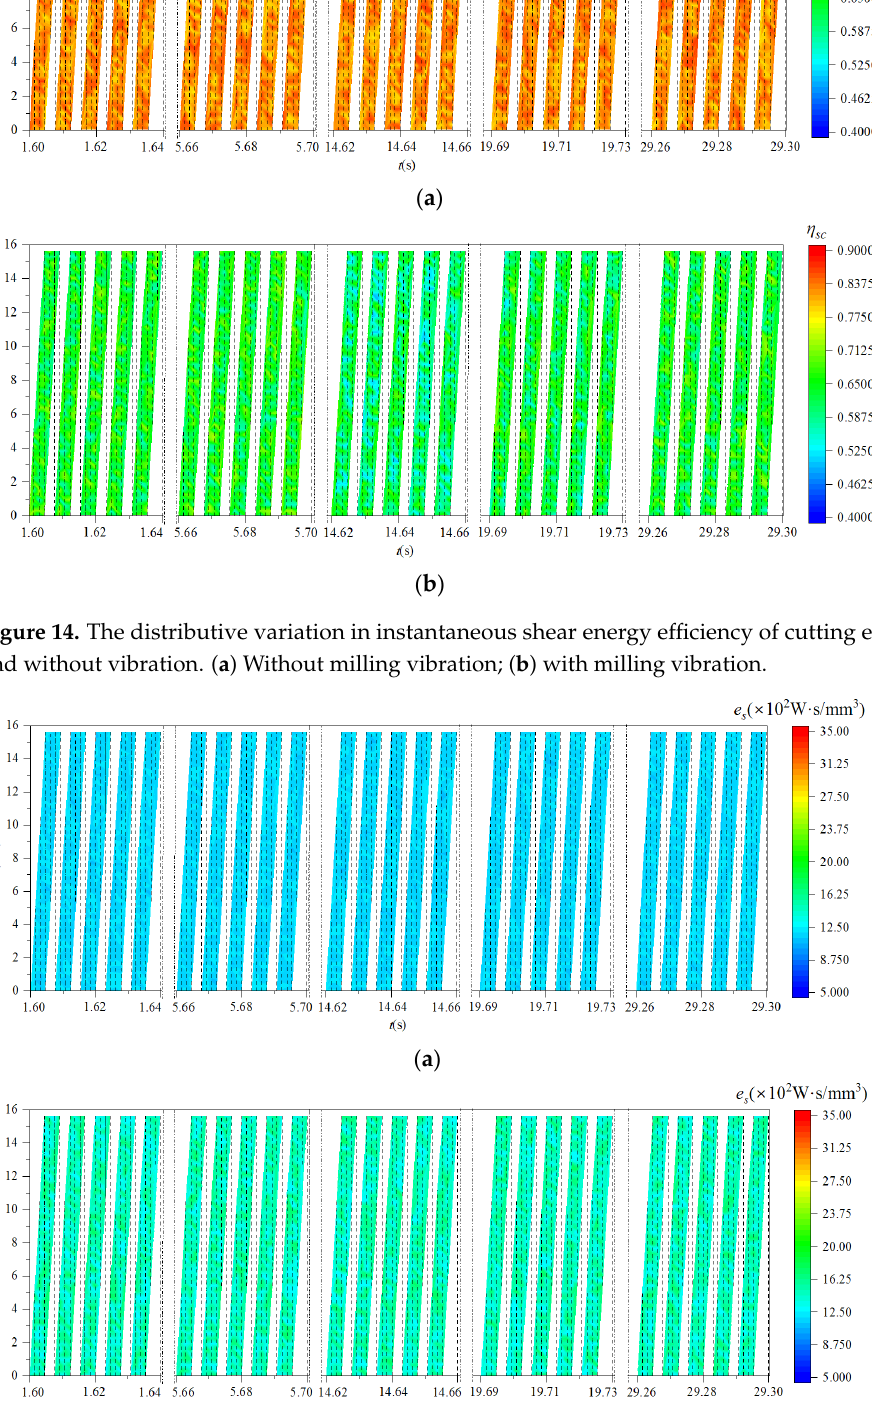
Figure 15. The distributive variation in instantaneous specific shear energy of cutting edge with and without vibration. ( a ) Without milling vibration; ( b ) with milling vibration.